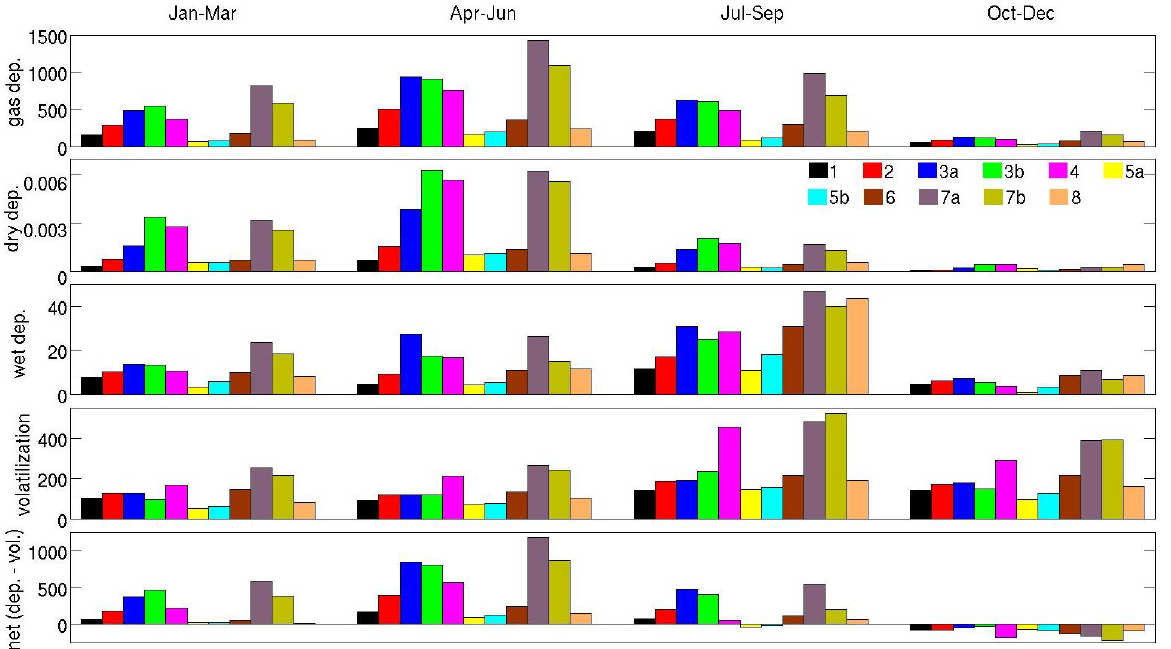
Figure 7. Bar charts of integrated quarterly (3 month) fluxes (kg) by ICES boxes (Figure 1) of γ-HCH in 2004: gas deposition ( top row ), dry deposition ( 2nd row ), wet deposition ( 3rd row ), volatilization ( 4th row ), and net air-sea exchange ( bottom row